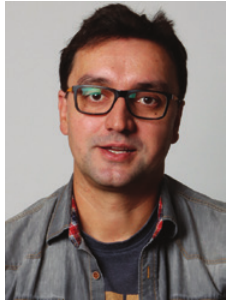
Figure 5 Antonio Reis (Source: photograph by